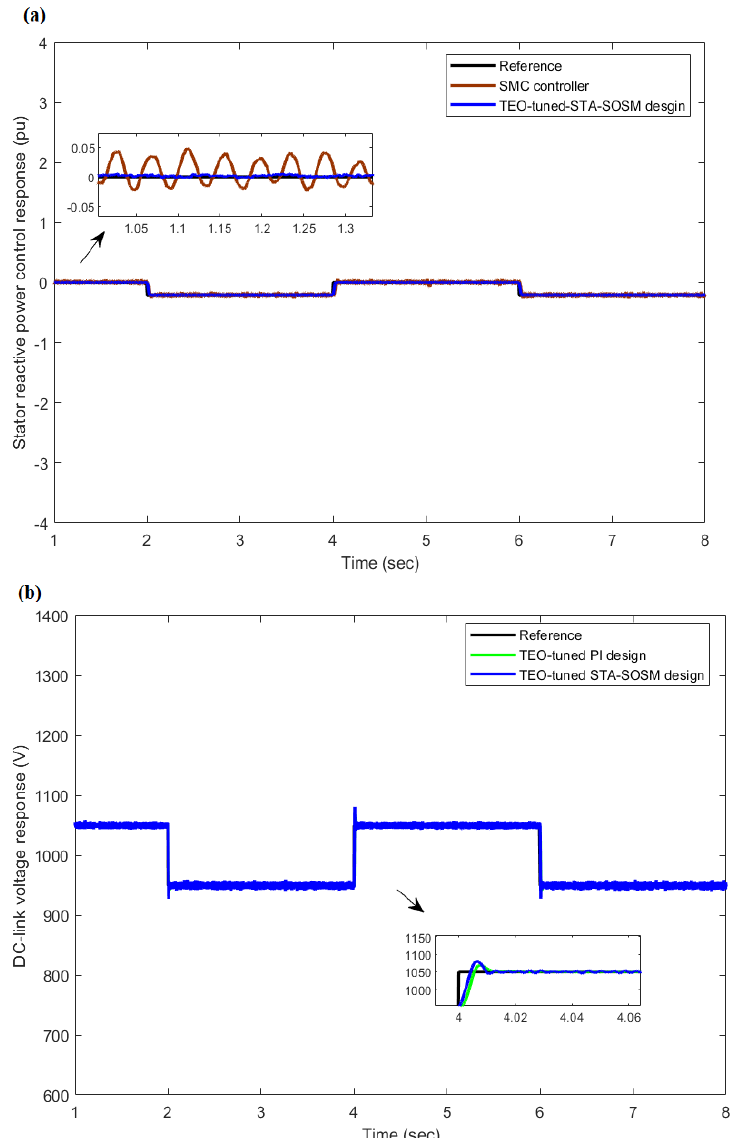
Figure 7. Performance comparison: ( a ) stator reactive power; ( b ) DC-link voltage.